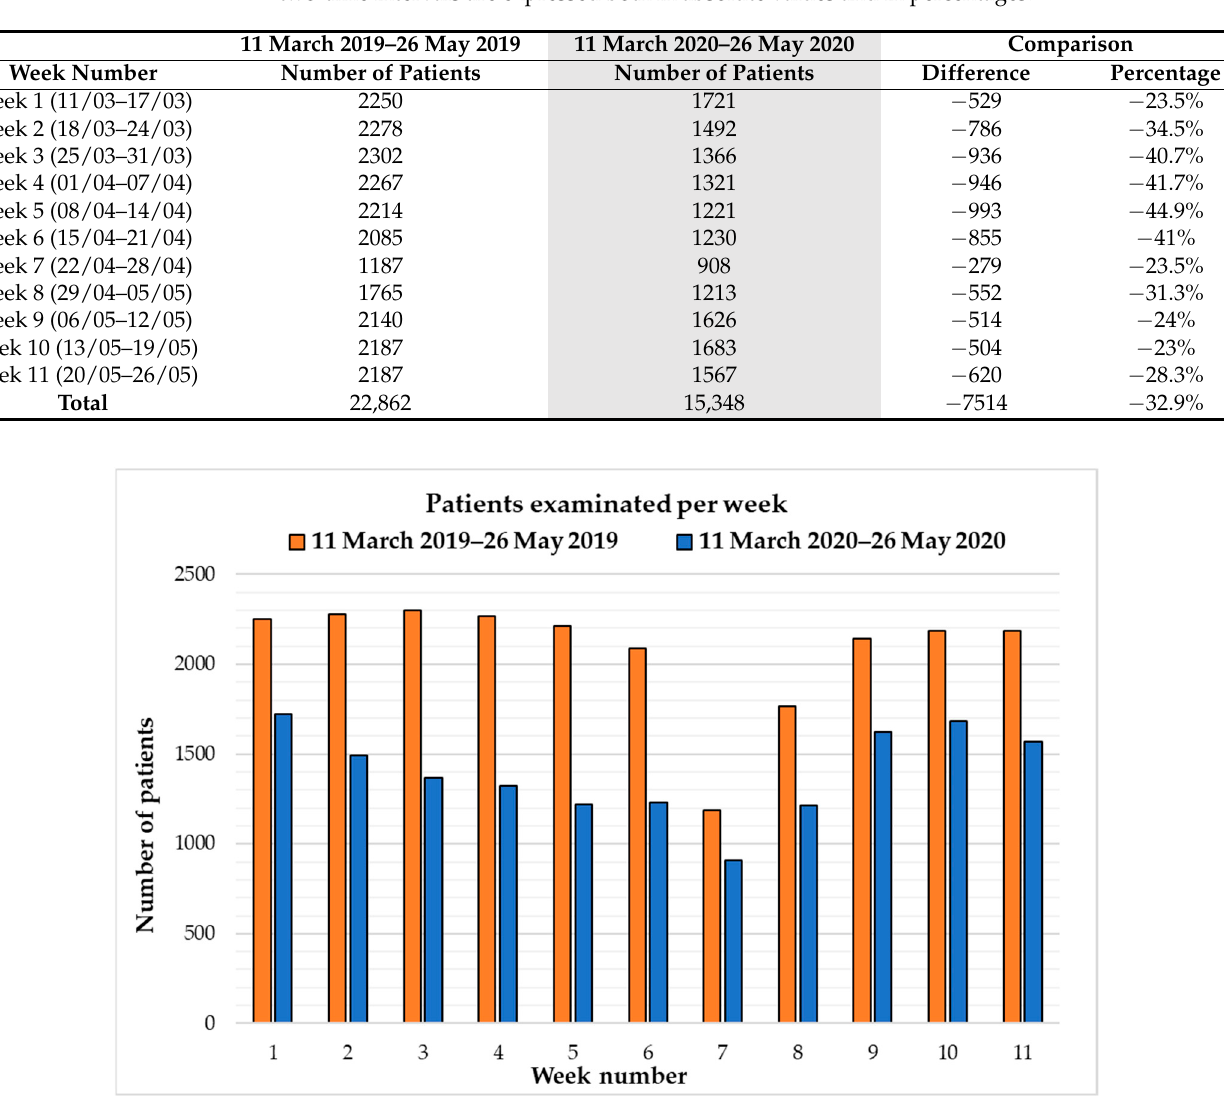
Figure 2. Graphical comparisons between the number of patients who underwent diagnostic exam-